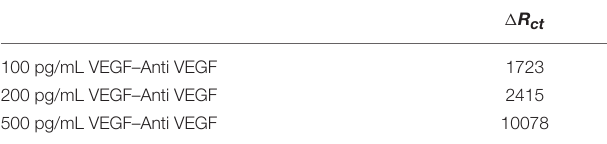
TABLE 2 | The normalized 1 R ct as a function of VEGF